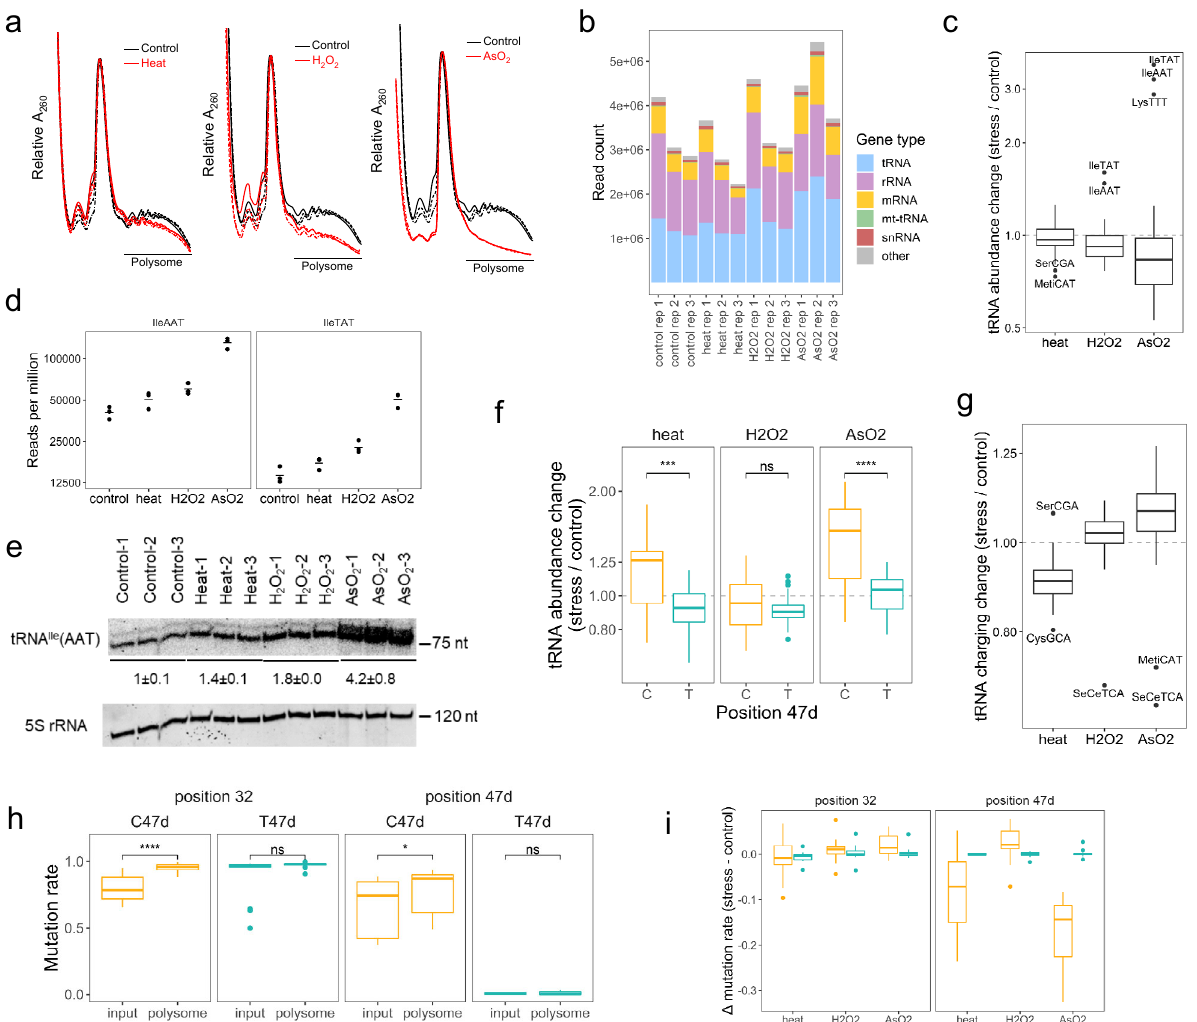
Fig. 4 tRNA analysis of polysome under stress. MSR-seq was performed in biological triplicates ( n = 3) for each condition. Box and Whisker plots show median, 25th and 75th quartile, and whiskers to 1.5 times interquartile range. a Polysome pro fi le from sucrose density gradient. Unstressed control in black and stress in red. The three independent biological replicates are shown. The line “ polysome ” indicates the pooled fractions for MSR-seq. b Read coverage among RNA families for each sample. c Stress-induced changes in abundance of tRNA isoacceptor families on the polysome are calculated as in Fig. 3b, averaged across n = 3 independent biological replicates, displaying 46 isoacceptor families. d Normalized abundance of polysome-associated tRNA Ile (AAT) and tRNA Ile (TAT). e Validation of tRNA Ile (AAT) change on polysome by Northern blot. 5 S rRNA is the loading control. All data for n = 3 independent biological replicates is shown. Source data are provided as a Source Data fi le. f Abundance change for C47d-tRNA Ser isodecoders in orange and T47d-tRNA Ser in blue. **** p < 10 − 4 , *** p < 10 − 3 , ns not signi fi cant; signi fi cance calculated with two-sided t -test. Data were shown for n = 3 independent biological replicates of 8 and 6 C or T tRNA Ser isodecoders, respectively. P values are 7.4 × 10 − 4 and 6.6 × 10 − 4 for Cand T isodecoders. g Stress-induced change in tRNA charging on the polysome; charging is calculated as in Fig. 3c. averaged across n = 3 independent biological replicates, displaying 46 isoacceptor families. h Comparing mutation fraction of position 32 and 47d of tRNA Ser isodecoders in the total RNA (input) and on polysome of the unstressed control. C47d-tRNA Ser isodecoders in orange and T47d-tRNA Ser in blue. **** p < 10 − 4 , * p < 0.05, ns not signi fi cant; signi fi cance calculated with two-sided t -test. Data were shown for n = 3 independent biological replicates of 8 and 6 C or T tRNA Ser isodecoders, respectively. P values are 3.4 × 10 − 8 and 2.0 × 10 − 2 for positions 32 and 47d. i Stress-induced m 3 C32 and m 3 C47d change of tRNA Ser isodecoders. C47d-tRNA Ser isodecoders are in orange, T47d-tRNA Ser in blue. Data were shown for n = 3 independent biological replicates of 8 and 6 C or T tRNA Ser isodecoders,